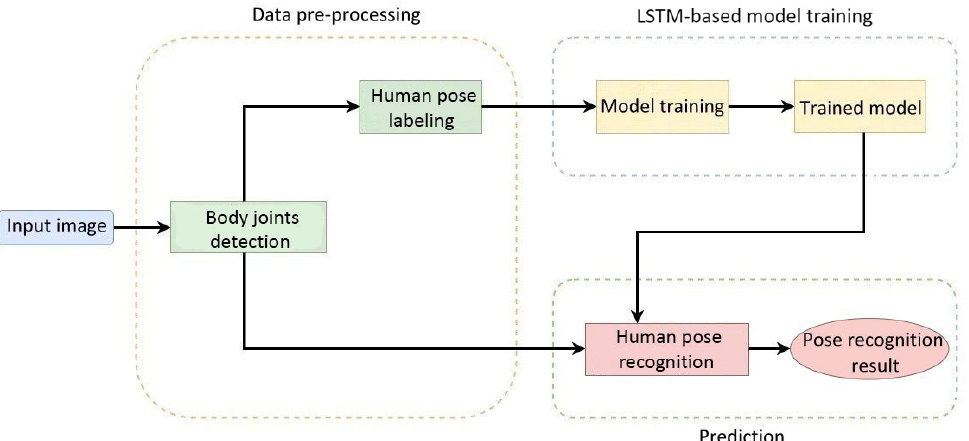
Figure 5. Flowchart of the human pose image recognition system.